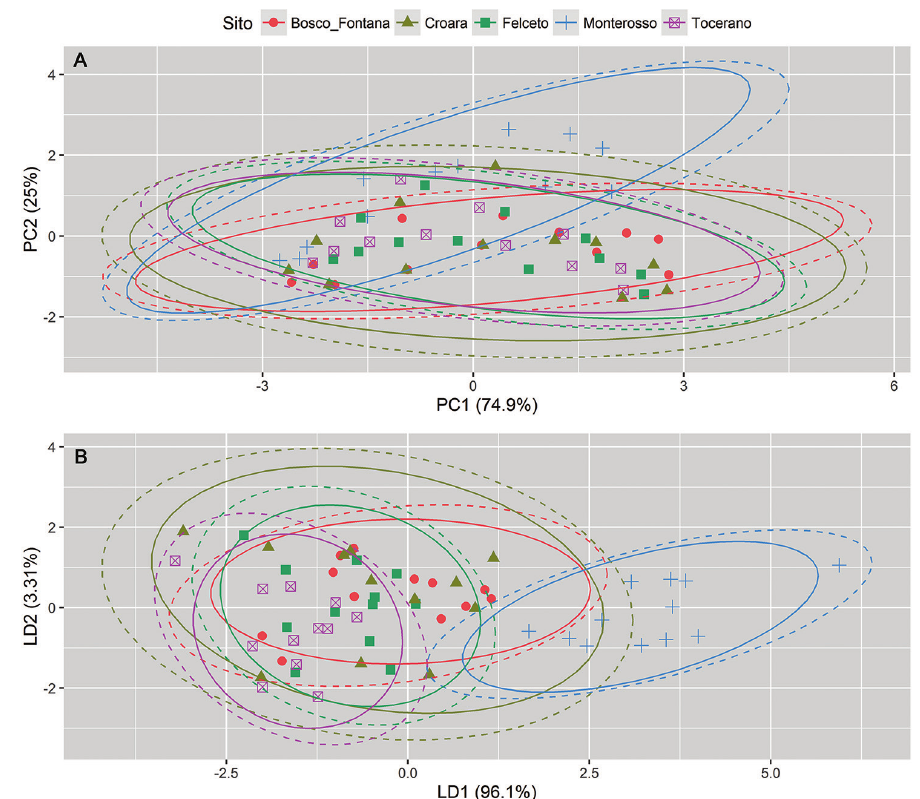
Figure 2. Scatterplots for the variation of climate variables amongst the sites: A first two principal com- ponents of the PCA B first two linear discriminants of the LDA. The percentage of variance explained by each axis was reported in